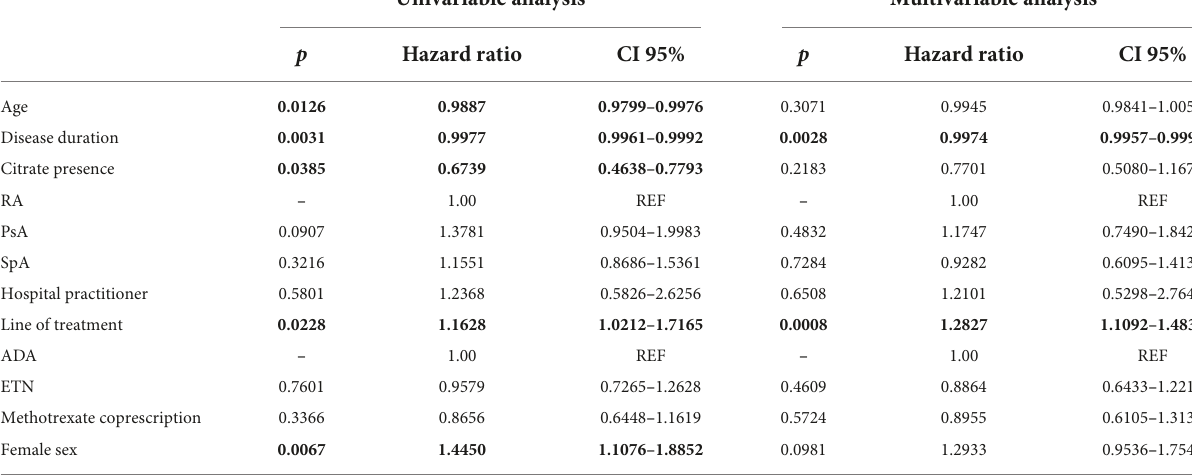
TABLE 3 Predictive factors of bsDMARDs’ cessation in univariable and multivariable analyses.